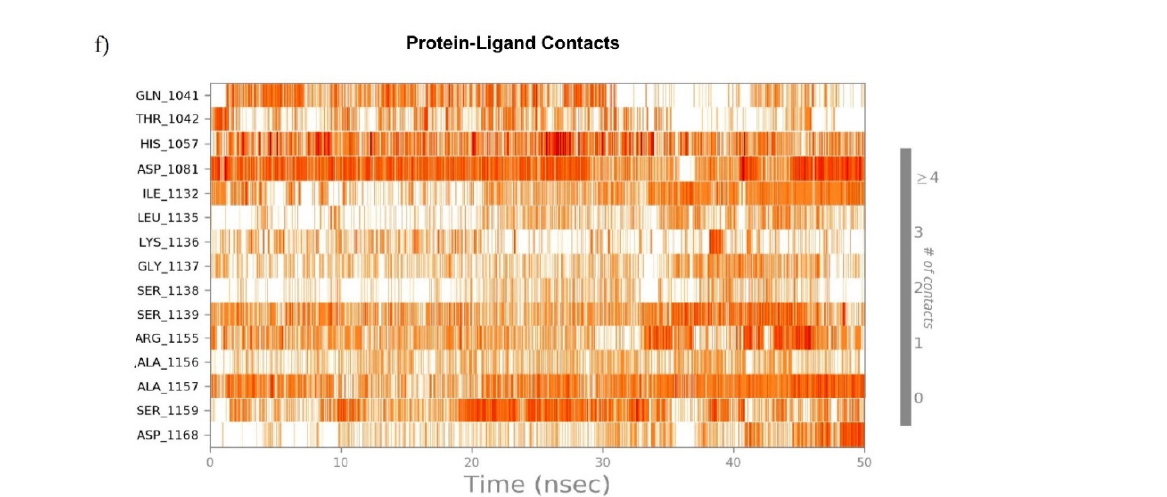
Figure 10. Stability of chebulagic acid with HCV NS3/4A at 50 ns of simulation: ( a ) RMSD, ( b ) RMSF, ( c ) rGyr, and ( d – f ) residue-wise ligand–protein contacts.